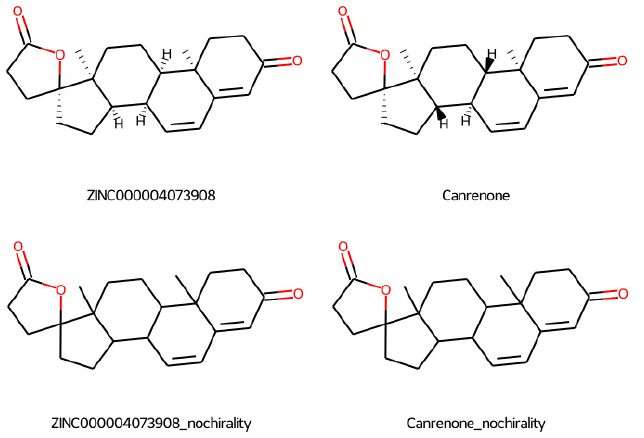
Figure 9. Our lead ZINC000004073908 and Canrenone side to side, with and without chirality